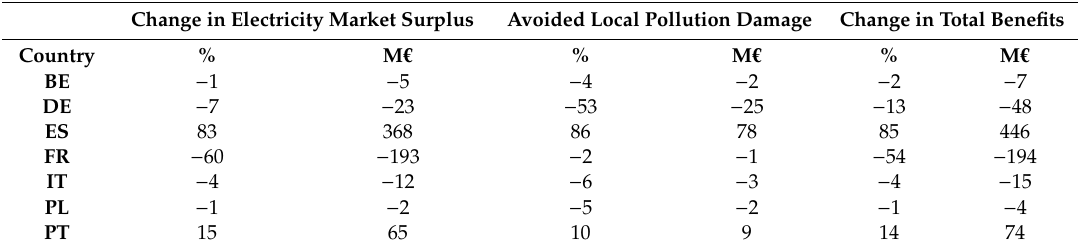
Table 7. The breakdown of the ALPD, and the change in EMS and TB, for selected countries for Vision 1 in 2030.